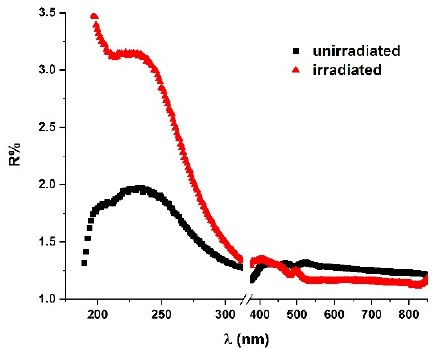
Figure 9. UV–Vis–NIR reflectance spectra of W / O emulsion 50% ( v / v ) oily vitamin A, before and after laser radiation exposure ( λ = 532 nm, E = 35 mJ, t = 1 h).